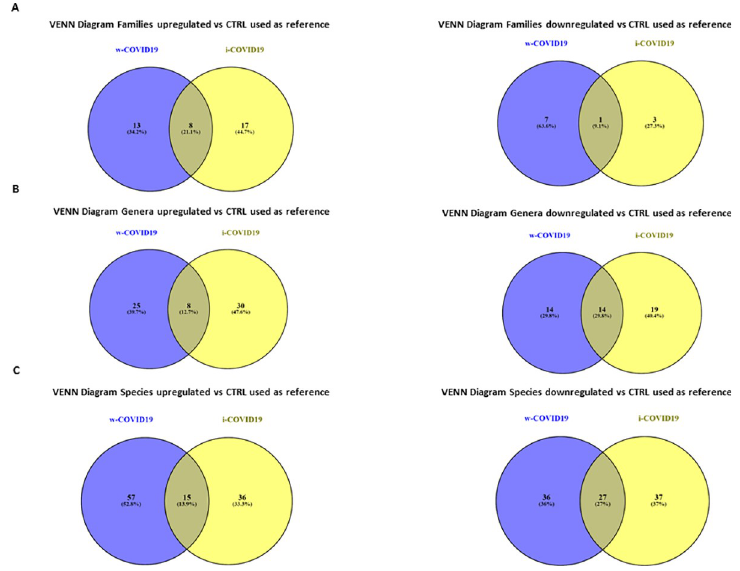
Fig 8. Venn diagrams showing the number of distinct and shared families (A), genera (B) and species (C) up and decreased between subjects grouped by w-COVID19, i-COVID19 patients as compared to CTRL used as